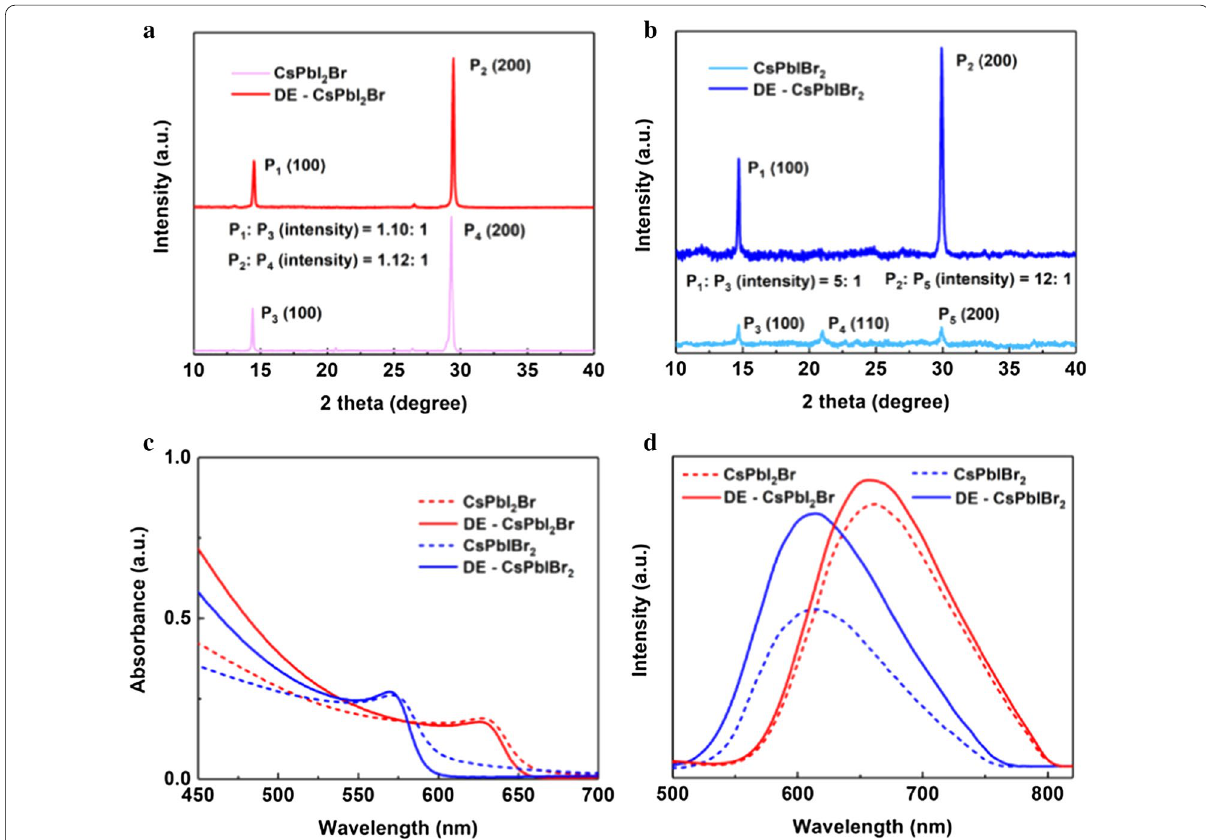
, d photoluminescence spectra of − x